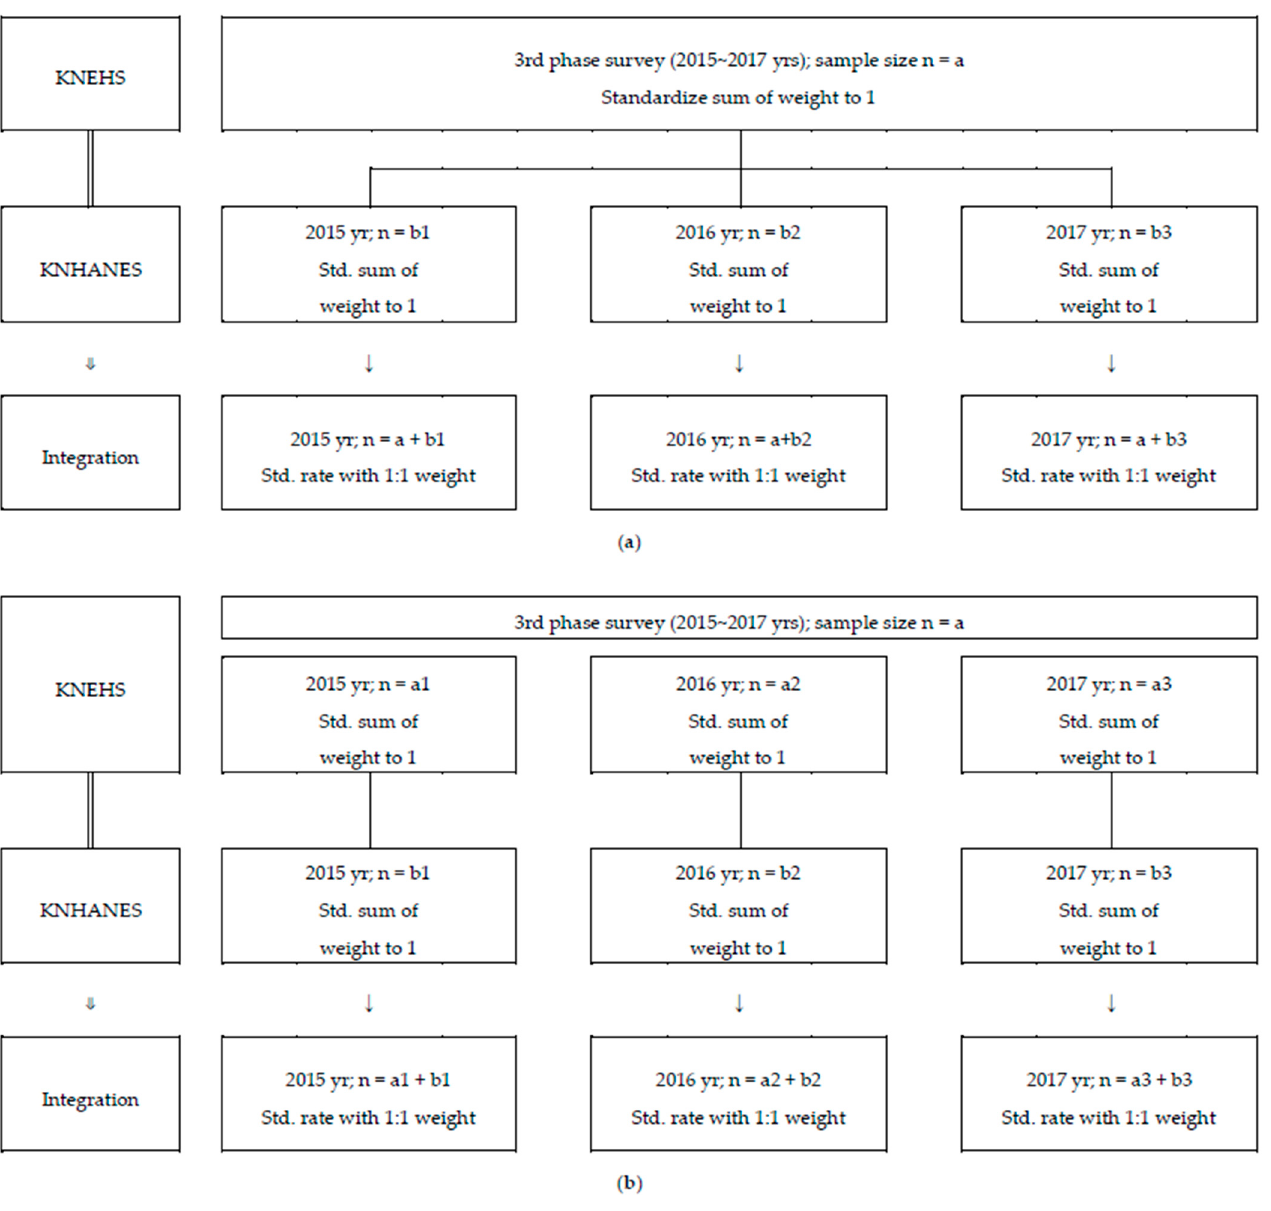
Figure 2. Example of KNEHS and KNHANES integrated data generation methods. ( a ) Method 1: Integrating phase data of KNEHS and yearly data of KNHANES to equal weights. ( b ) Method 2: Integrating yearly data of KNEHS and KNHANES to equal weights. KNEHS, Korean National Environmental Health Survey; KNHANES, Korea National Health and Nutrition Examination Survey; Std, standardized.